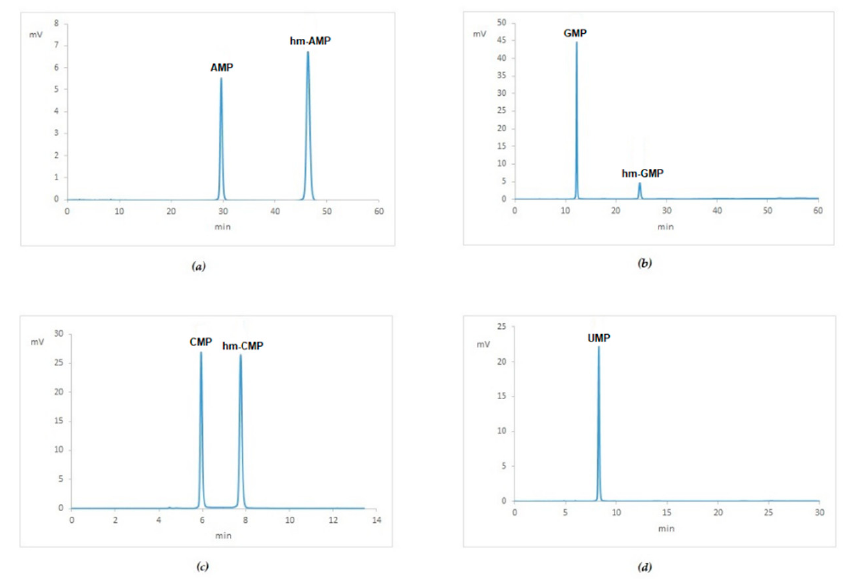
Figure A2. Chromatogram of: ( a ) hydroxymethyl-AMP 1b (peak 2) and unmodified AMP 1a (peak 1); ( b ) hydroxymethyl-GMP 2b (peak 2) and unmodified GMP 2a (peak 1); ( c ) hydroxymethyl-CMP 3b (peak 2) and unmodified CMP 3a (peak 1); ( d ) unmodified UMP 4a .